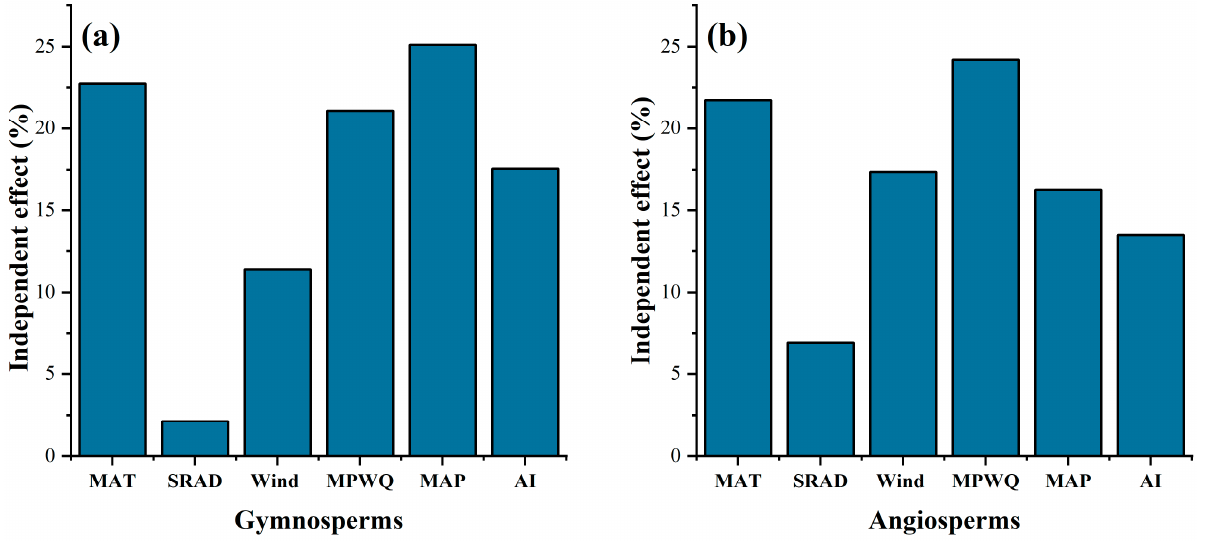
Figure 7. Independent effects of environmental factors on seed mass. ( a ) Gymnosperms. ( b ) Angiosperms. MAT: mean annual temperature. Wind: wind speed. MPWQ: precipitation of the warmest quarter. SRAD: solar radiation. MAP: annual precipitation. AI: aridity index.